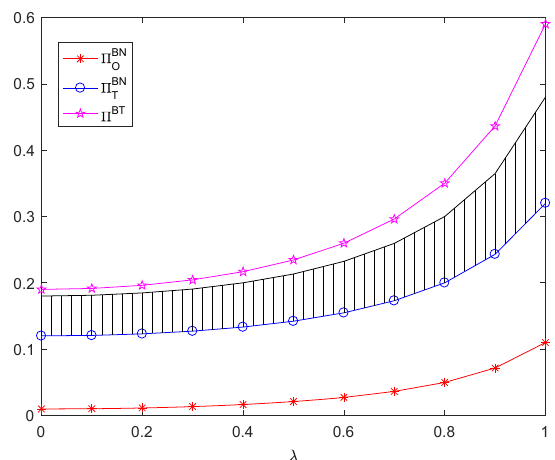
Figure 7. The range of fixed payments with blockchain technology.